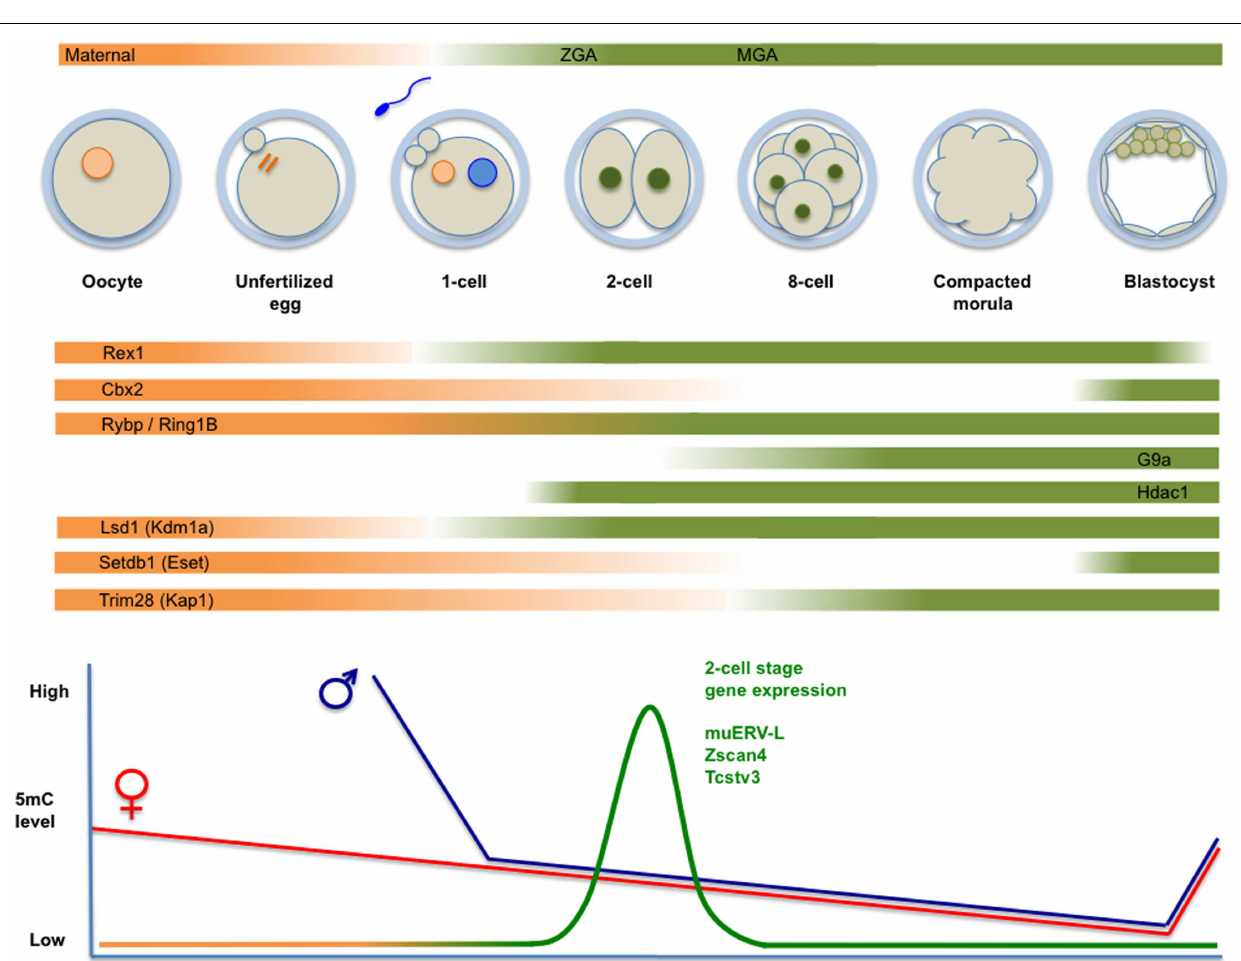
FIGURE 2 |Top panel: schematic representation of fertilization, formation of the zygote, and cleavage divisions, followed by the successive generation of morula and blastocyst .Transcripts derive from maternal deposits, or correspond to the two transient waves of de novo transcription: zygotic gene activation (late zygote-two-cell) or ZGA, and mid pre-implantation gene activation (MGA).The temporal changes in expression levels of